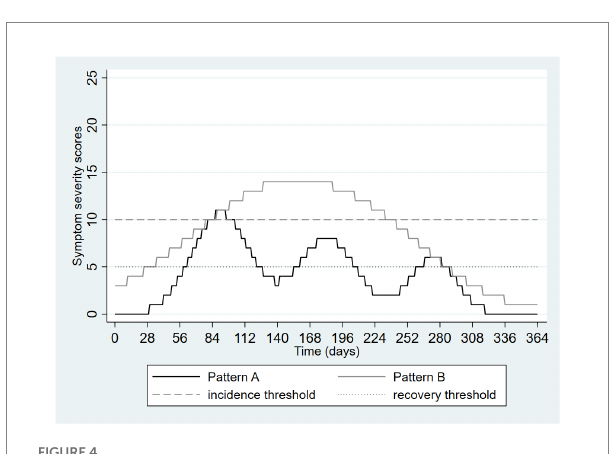
FIGURE 4 Hypothetical pattern of symptom severity over one year, depicting a loss of information due to categorization using thresholds: different patterns are made to seem similar.